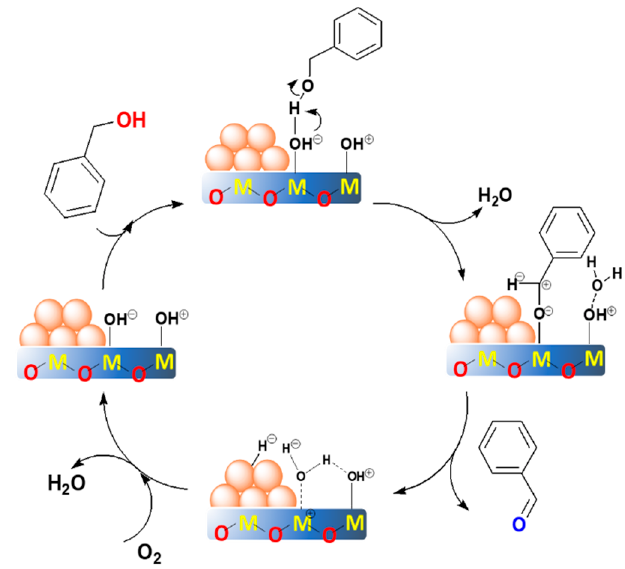
Figure 10. The proposed reaction mechanism over the supported gold catalysts with the synergetic acid-base sites. The M refers to the metal cation.